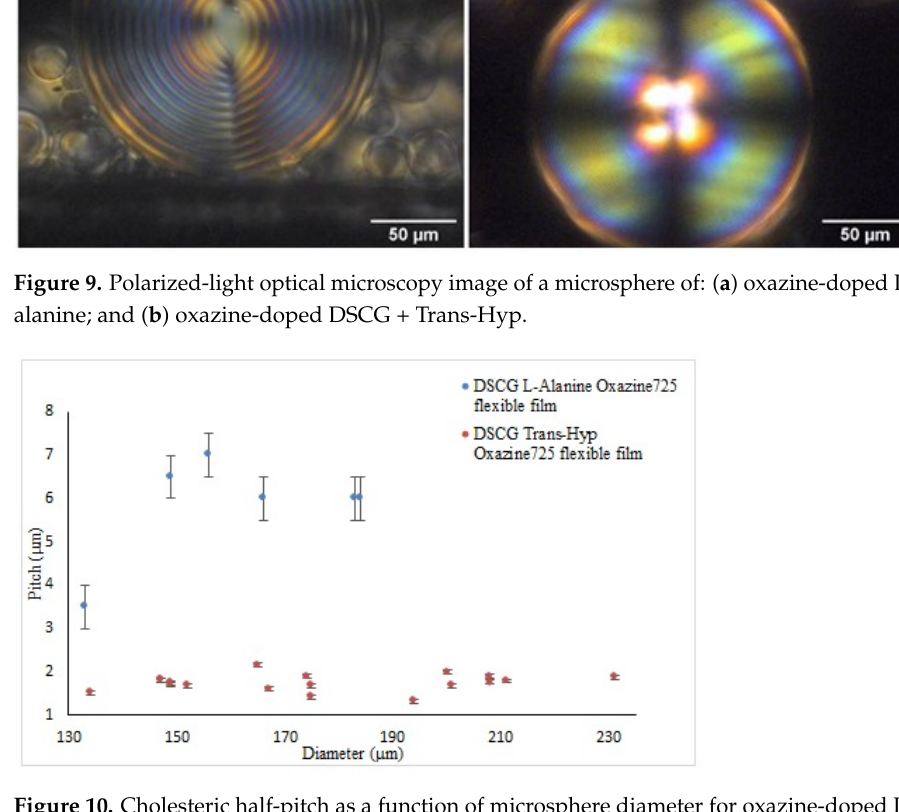
Figure 9. Polarized-light optical microscopy image of a microsphere of: ( a ) oxazine-doped DSCG + L-alanine; and ( b ) oxazine-doped DSCG + Trans-Hyp.